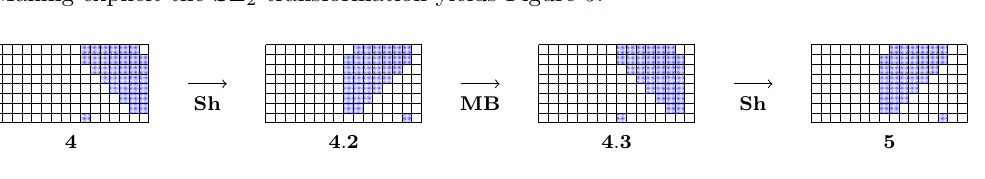
Figure 5: The truncated differential path verified by elements of the set ∆ 1 .